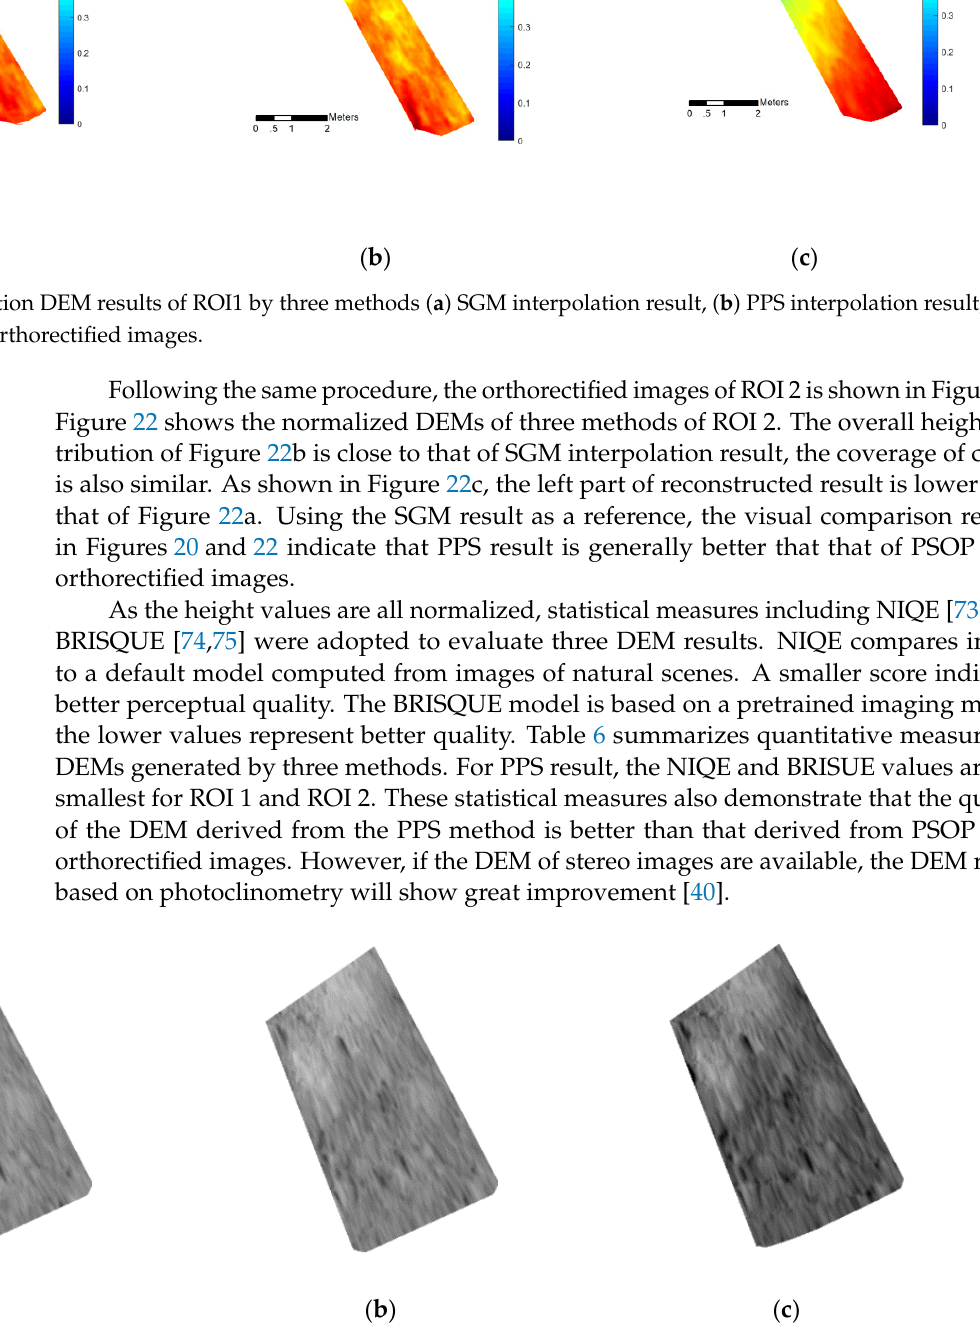
Figure 21. Orthorectified images of ROI 2 in Yutu-2 rover imagery ( a ) ROI 2 of 94741, ( b ) ROI 2 of 94914, ( c ) ROI 2 of 95633.